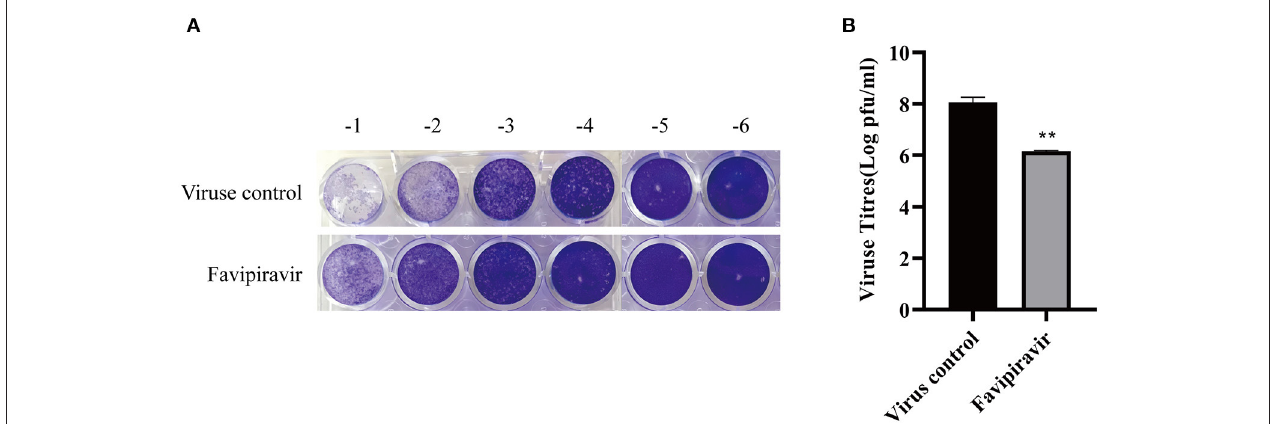
FIGURE 5 | The effect of favipiravir on the release of progeny peste des petits ruminants virus (PPRV) particles from host cells. (A,B) Vero cells were infected with 100 TCID 50 PPRV at 37 ◦ C for 2h and washed five times with cold phosphate-buffered saline (PBS) to remove unattached viruses, followed by supplementation with maintenance medium. The cells were incubated at 37 ◦ C for 48h and washed five times with cold PBS. Finally, the cells were incubated with maintenance medium containing favipiravir at 50 µ g/ml for 2h. The supernatants were collected, and the virus titers were determined by plaque formation assay (** p < 0.01 vs. the virus-only